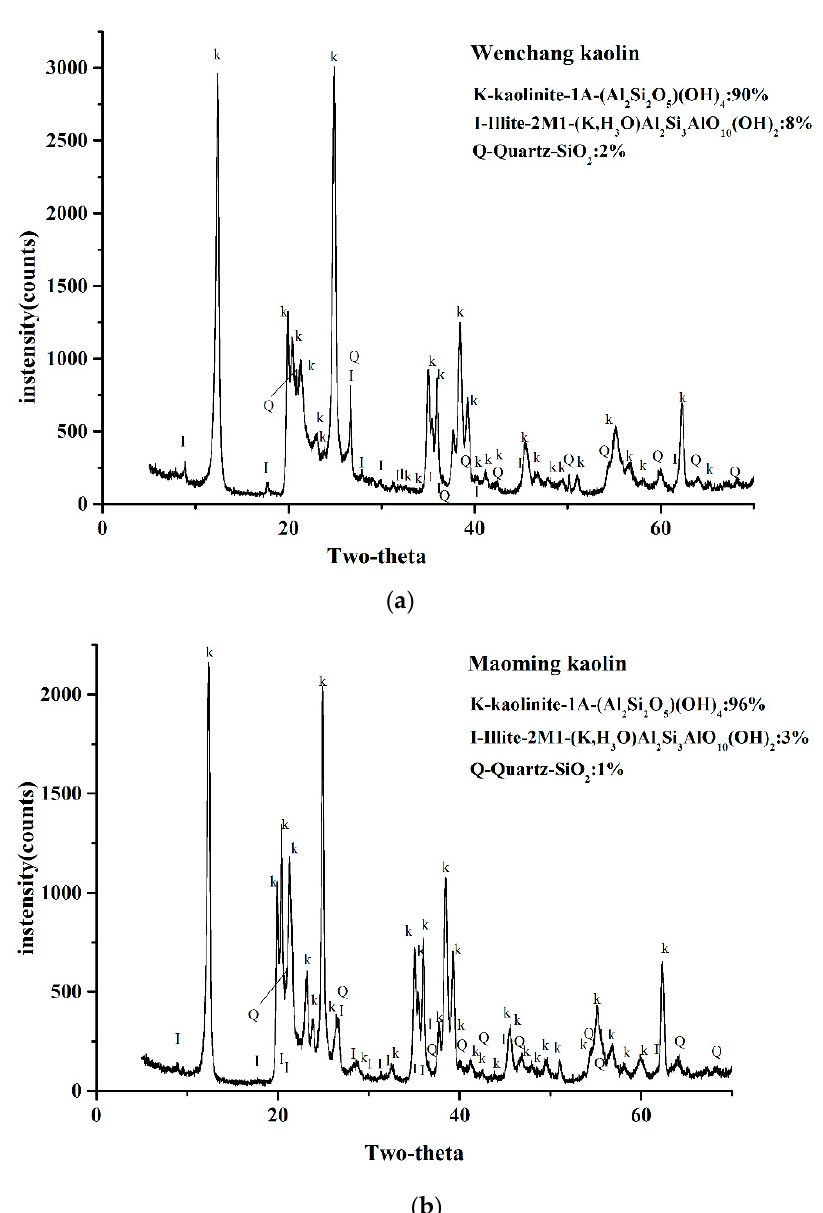
Figure 2. X-ray powder diffraction patterns of the two kaolinites.